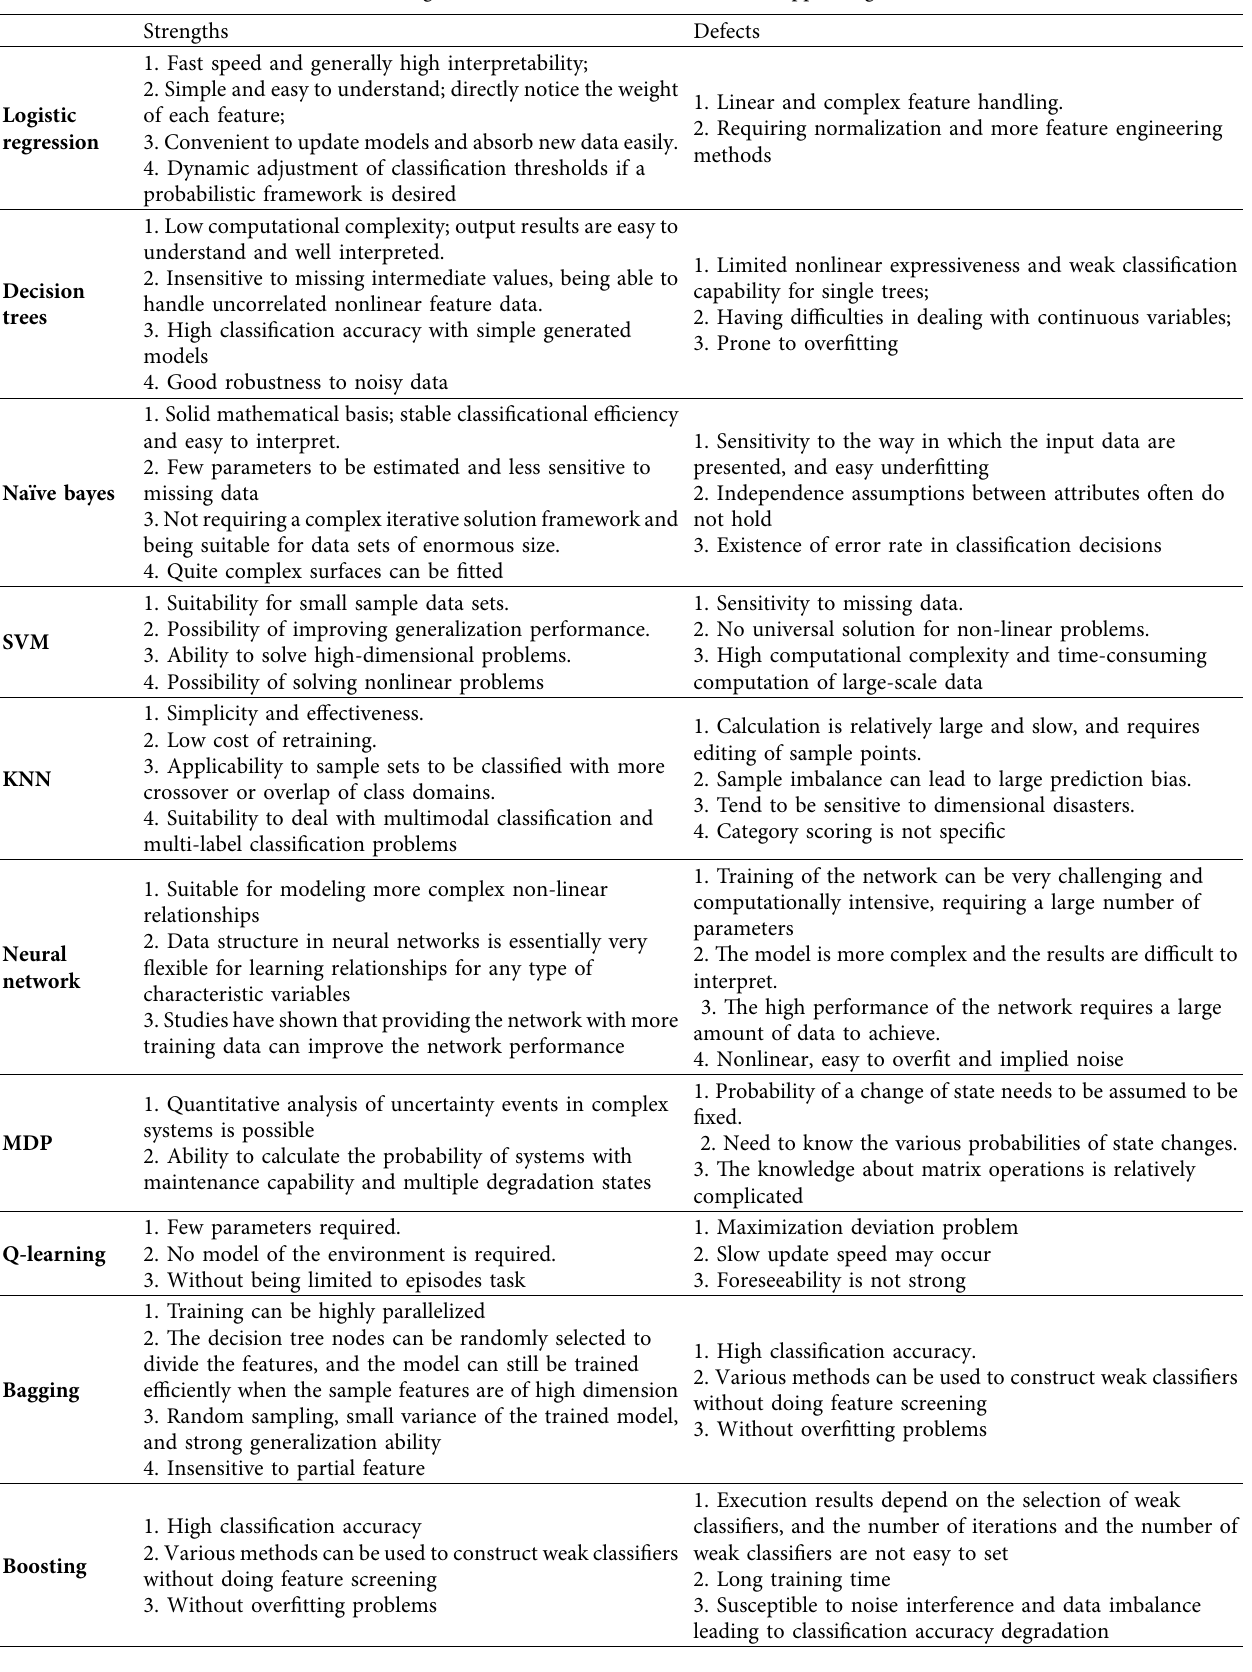
Table 4: Strengths and defects of different decision-support